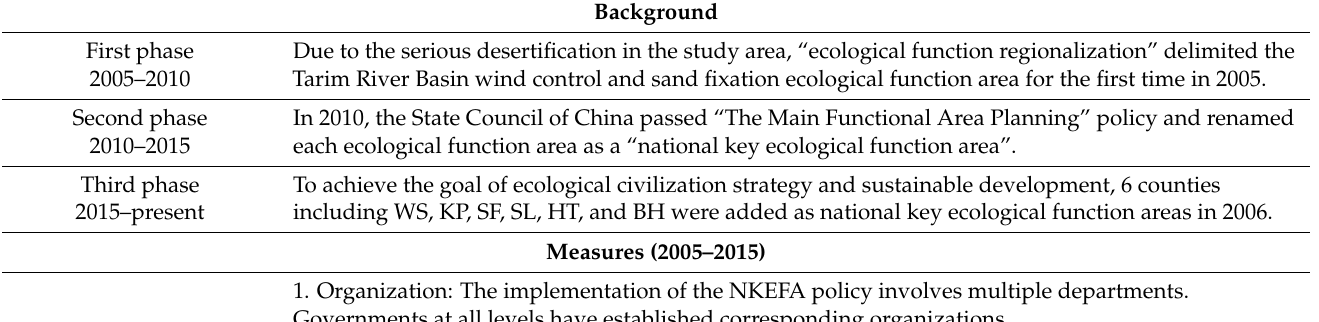
Table 2. Introduction of national key ecological function area (NKEFA) policy in marginal parts of the Taklimakan Desert.